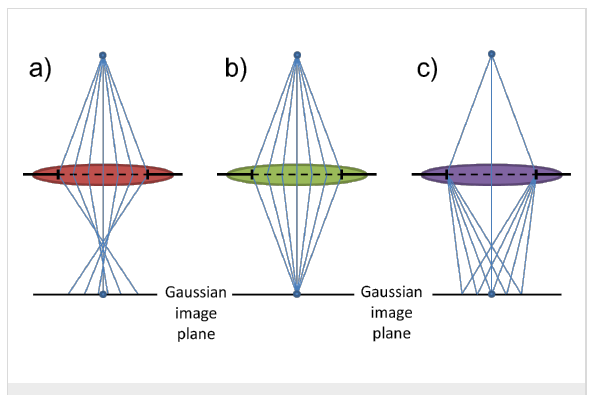
Figure 1: Illustration of (a) spherical aberration (b) ideal lens and (c) chromatic